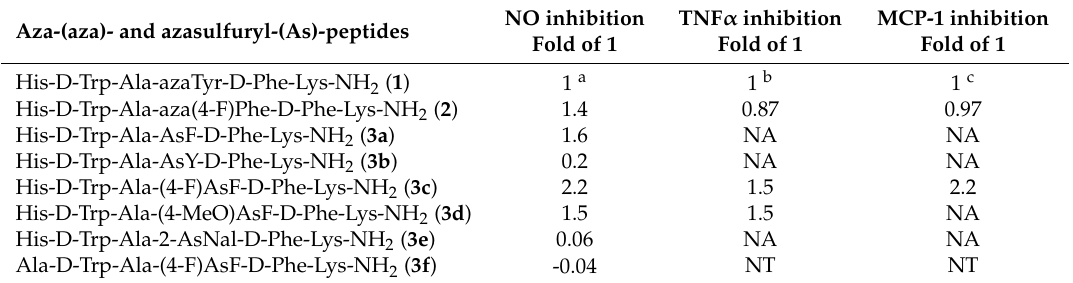
Table 2. In vitro assessment of anti-inflammatory activity of azasulfurylpeptide in macrophages. Aza-(aza)- and azasulfuryl-(As)-peptides